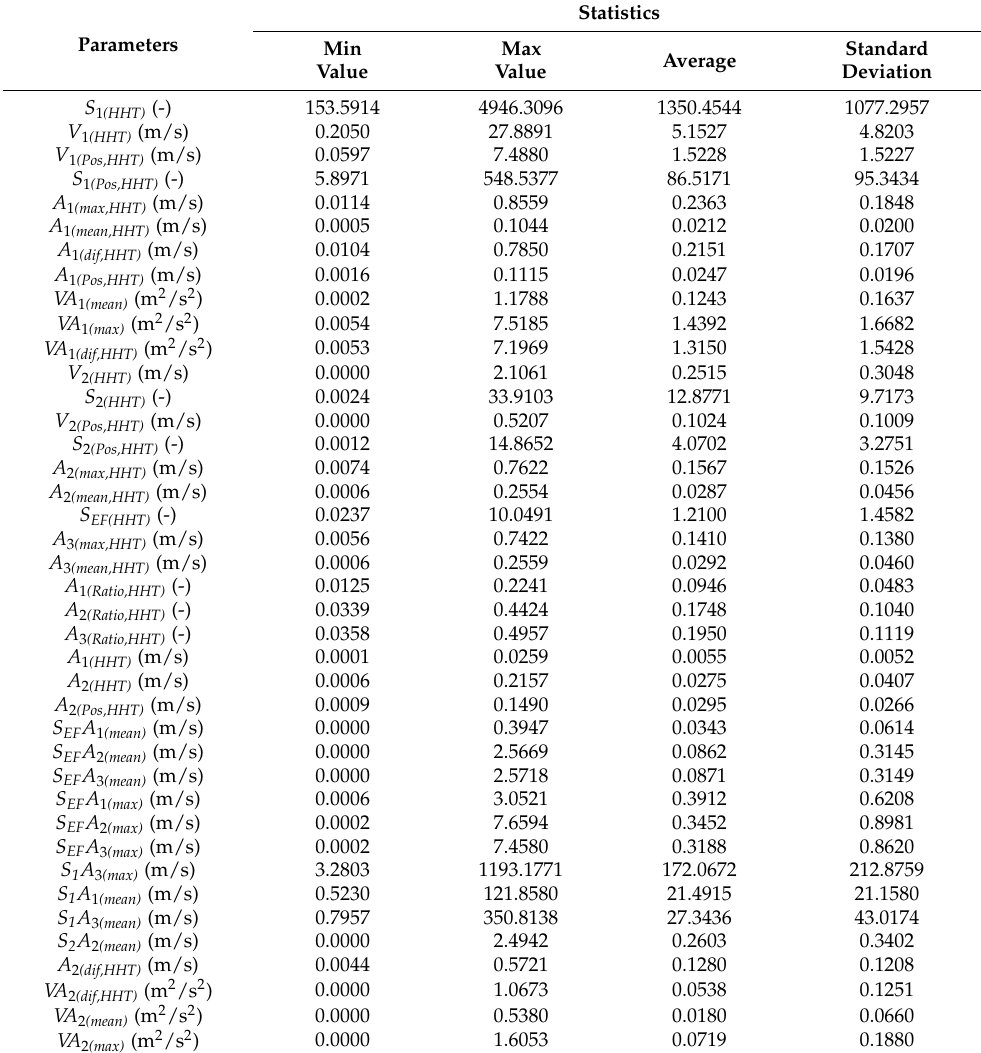
Table 2. T Statistical results of HHT-based seismic